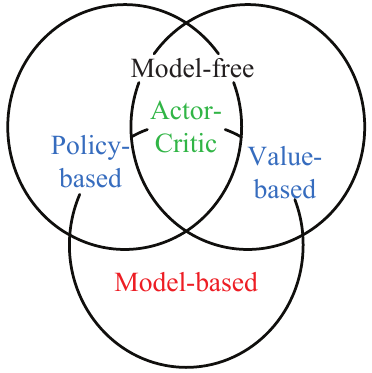
Figure 2. The classification of reinforcement